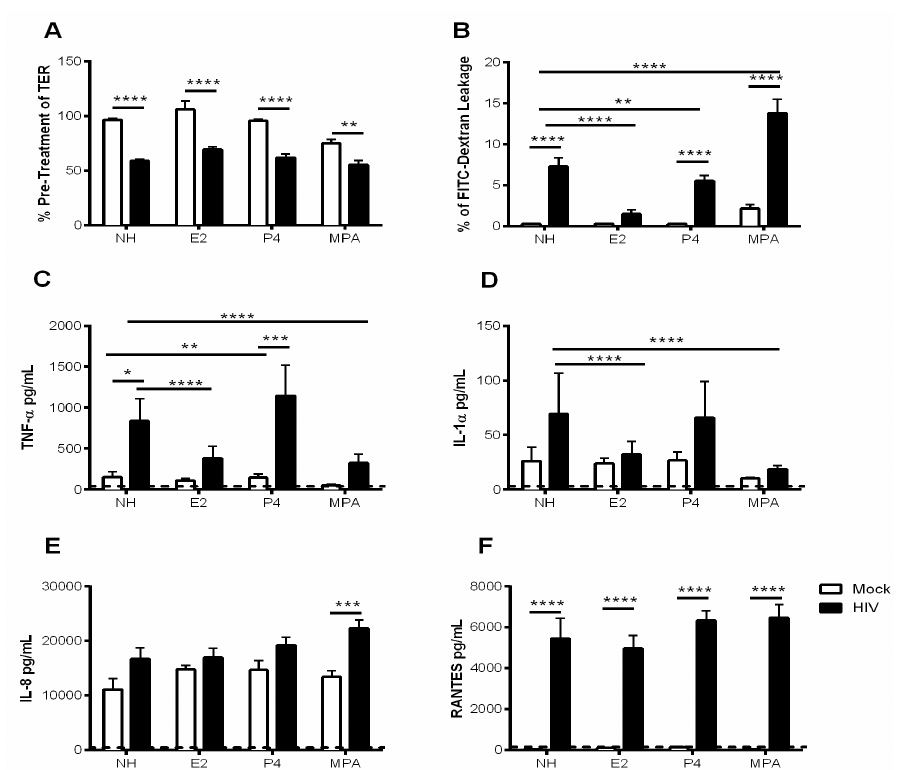
Figure 4. Estrogen treatment prevents HIV-1-mediated barrier disruption in GECs. GECs were grown in the absence (NH) or presence of sex hormones E2, P4 or MPA until confluence was reached. GECs were then exposed to HIV-1 and monitored for 24 h. ( A ) TER values were observed at 0 h and 24 h after HIV-1 exposure and expressed as percent of pre-treatment TER. Data is derived from 3 separate GEC culture experiments, with a minimum of two replicates per experimental condition were included. ( B ) FITC-dextran leakage to basolateral compartment after 24 h exposure to HIV-1. The FITC-dextran leakage is expressed as a percentage of FITC-dextran added initially. ( C – F ) 24 h post HIV-1 exposure, cell supernatants were collected and analyzed for TNF- α , IL-1 α , IL-8 and RANTES. Dashed line indicates assay limit of detection. Representative data is shown from 5–8 separate experiments done on cells isolated from 5–8 di ff erent tissues obtained from di ff erent donors; each experiment had 3 replicate cultures for each experimental condition. Data is plotted as mean + SEM. Statistical significance is indicated: **** p < 0.0001, *** p < 0.001, ** p < 0.01, * p <